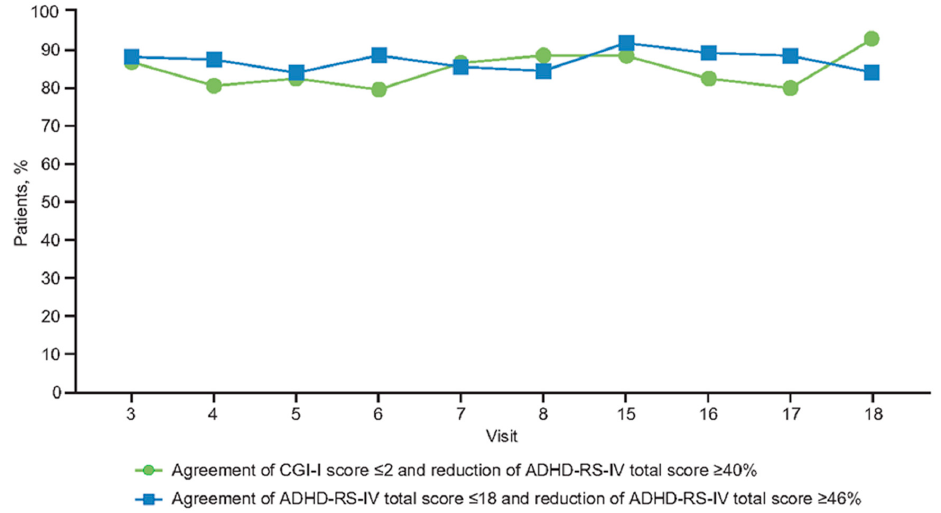
Figure 3. Percentage of patients with agreement between clinical response (CGI-I score ≤ 2) and a ≥ 40% reduction in ADHD-RS-IV total score, and the percentage of patients with agreement between an ADHD-RS-IV total score ≤ 18 and a ≥ 46% reduction in ADHD-RS-IV total score. Visits 15–18 were nominally every 2 months after completion of the open-label dose-optimization phase. ADHD-RS-IV: Attention-Deficit/Hyperactivity Disorder Rating Scale, Fourth Edition; CGI-I: Clinical Global Impressions-Improvement.